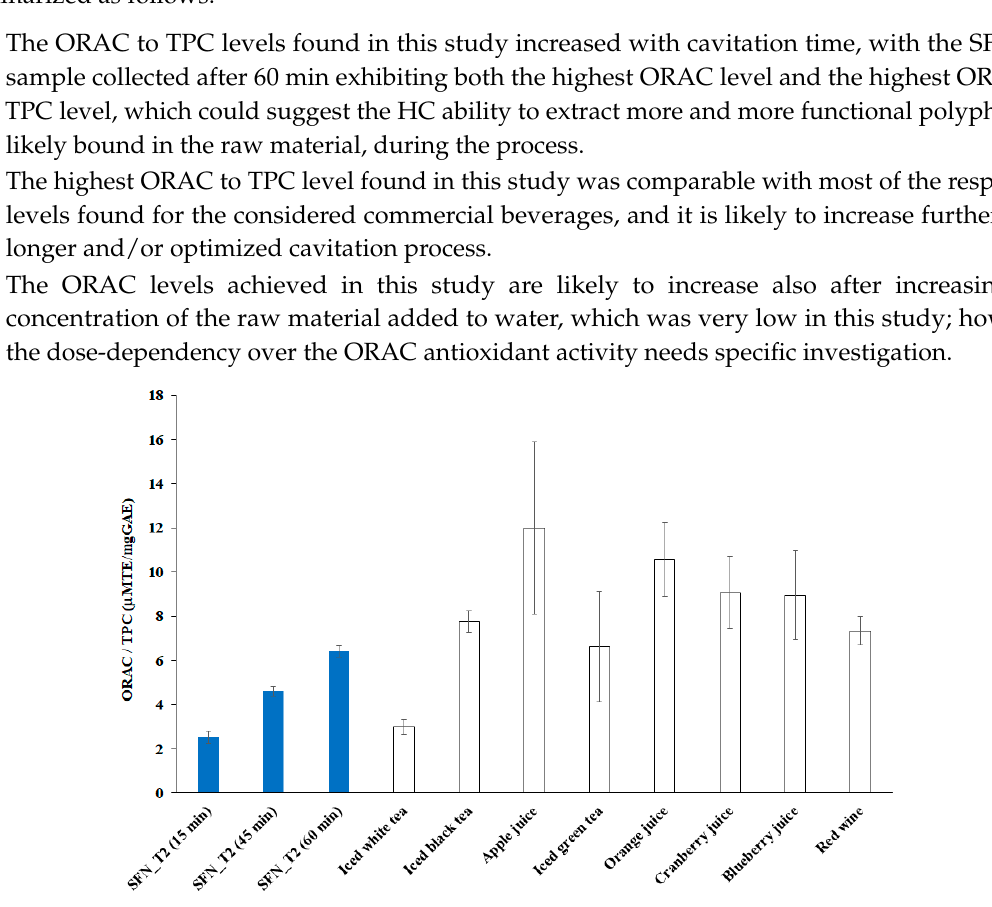
Figure 4. ORAC (The oxygen radical absorbance capacity) to TPC (The total phenolic content) ratios for three samples from the test SFN_T2 (this study) and referred to few commercial beverages. Thus, interesting perspectives exist about obtaining aqueous solutions, based on silver fir needles as raw material, and manufactured by means of the HC method proposed in this study, endowed with high ORAC levels. The above considerations also lead to recommending further research on the relationship between the ORAC antioxidant activity and the functional compounds extracted in the aqueous solution. Based on the nature of the raw material, the structural and operational features of the performed processes, and the obtained results, it is safe to state that the HC technique and the related